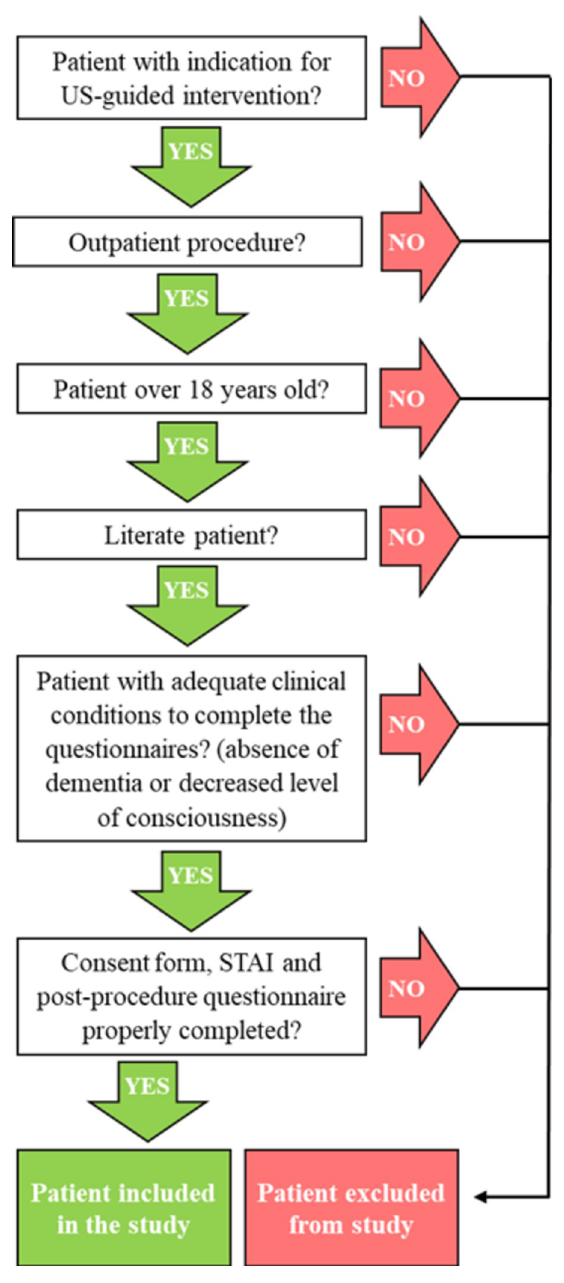
Fig 1. Inclusion criteria. STAI, State -Trait Anxiety Inventory; US,